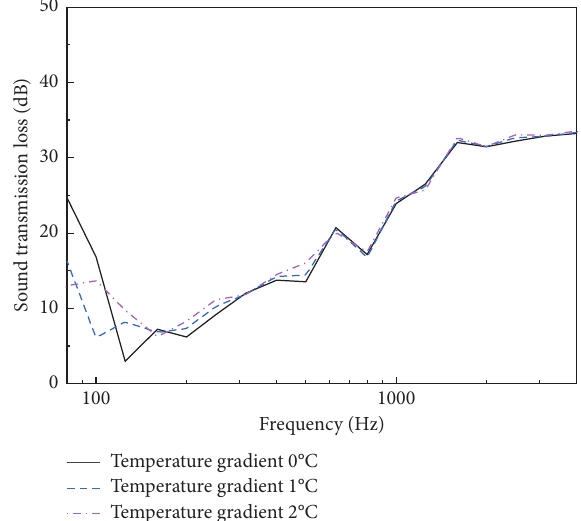
Figure 6: Influence of the temperature gradient on the sound insulation of a simply supported double-panel